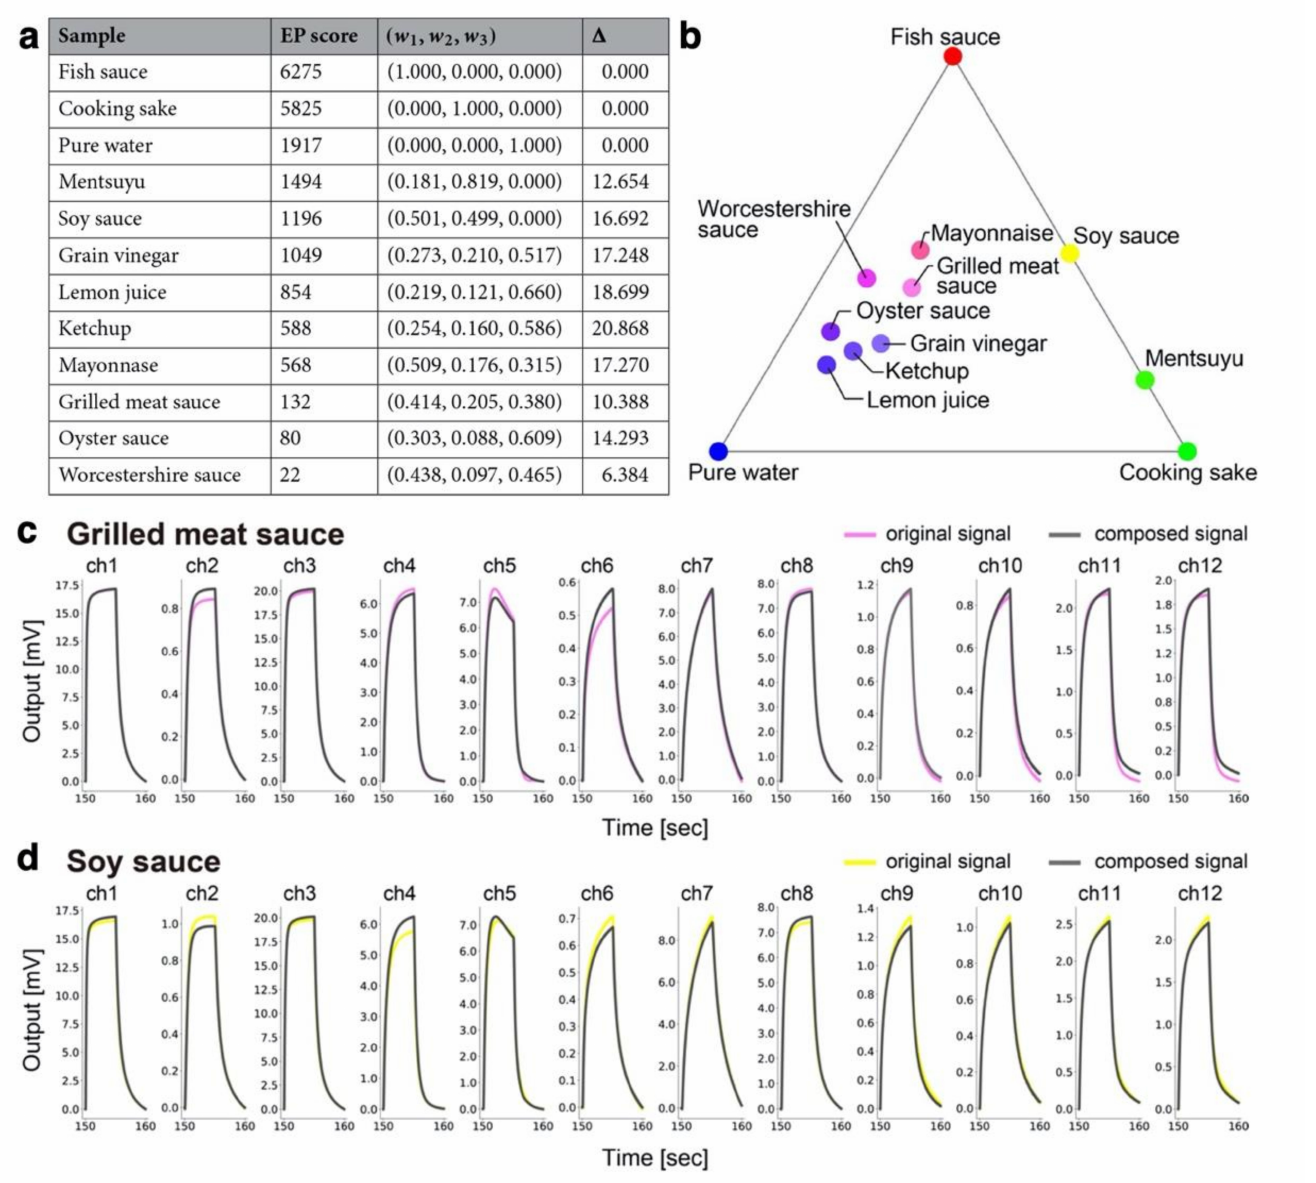
Figure 15. Determination of quasi-primary odors by endpoint detection. ( a ) Endpoint (EP) scores, mixture ratio ( w 1 , w 2 , w 3 ), and difference ∆ between original and composed signals. ( b ) Color map of pure water and 11 seasonings. Fish sauce (red), cooking sake (green), and pure water (blue) are selected as quasi-primary odors. ( c , d ) Original MSS signals and the composed signals for grilled meat sauce ( c ) and soy sauce ( d ). Reprinted from Ref. [10], the author licensed under CC-BY